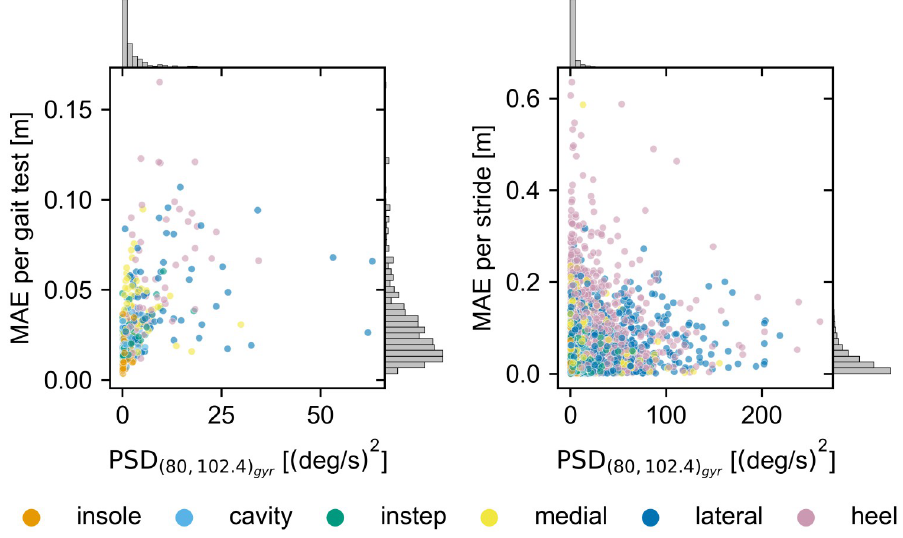
Fig 11. The correlation between PSD and the absolute stride length error. On the left the correlation on a ð 80 ; 102 : 4 Þ gyr gait test level is shown. For that the median PSD and stride length error for each of the six straight walk tests are calculated per participant and sensor. On the right the correlation on a stride level is shown for the same tests. The histograms in the margins show the relative distribution of values across all sensors along the respective